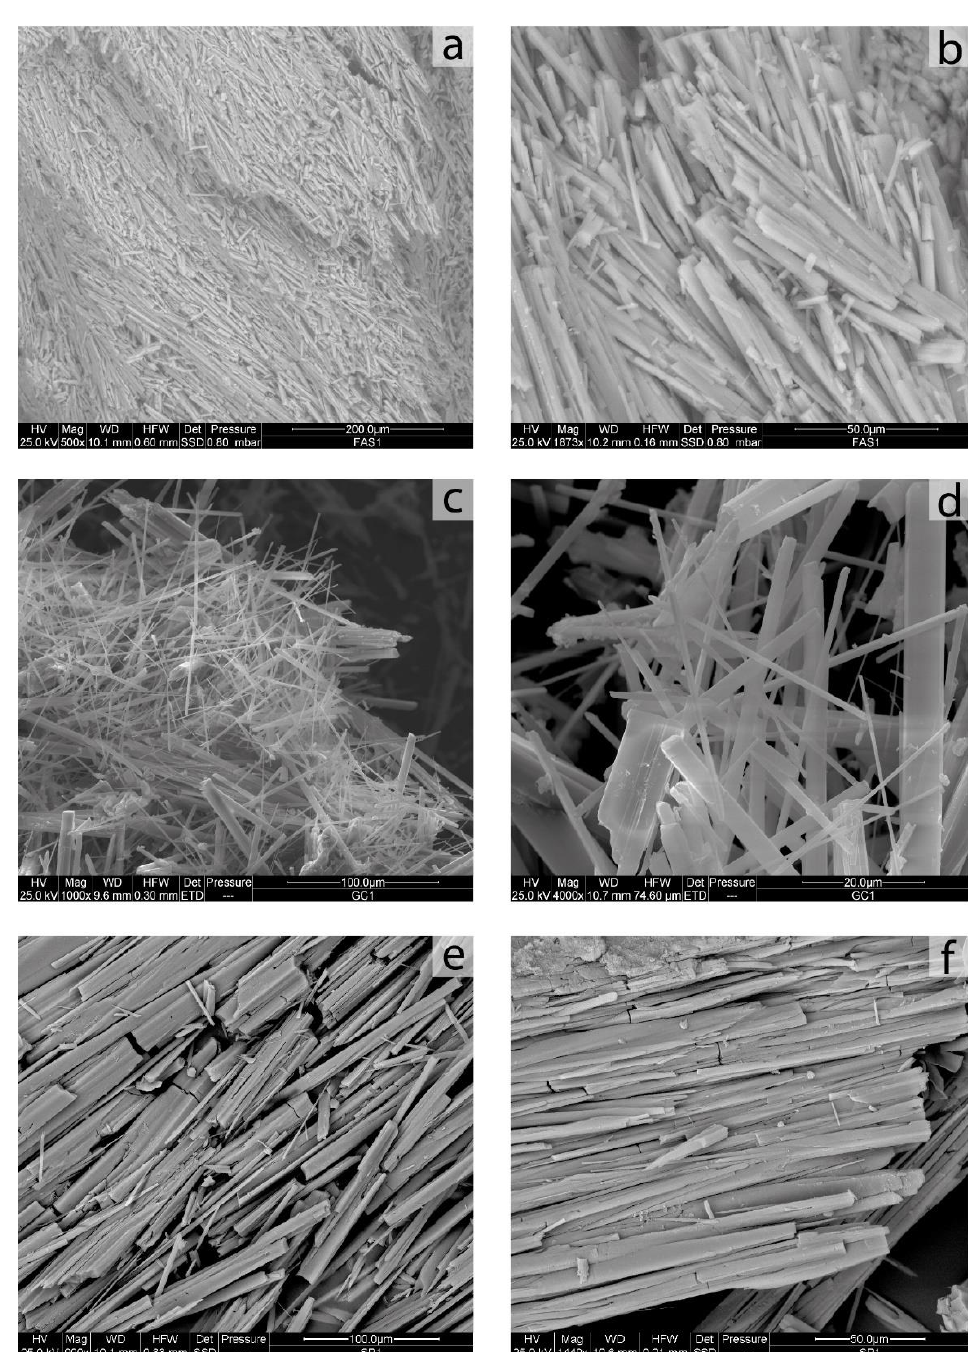
Figure 1. Representative SEM images of the studied samples. ( a ) Masses of elongated crystals of mordenite (FAS1); ( b ) detail of chaotic fragments and small fibers on the surface of the sample (FAS1); ( c ) panoramic image of woolly masses of fibers (GC1) and ( d ) particular of thin fibers and fragments (GC1); ( e ) image of prismatic-to-fibrous crystals of mordenite (SP1); ( f ) detail of small fragments and fibers present on the sample (SP1).